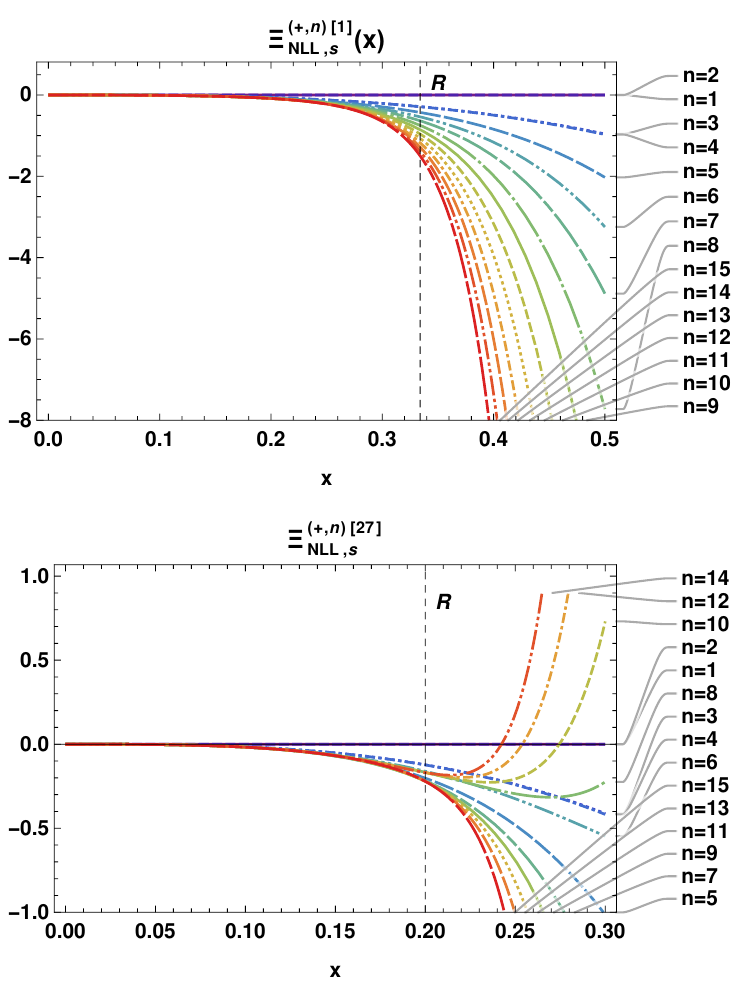
Figure 10 . Partial sums of the soft component of the infrared-renormalized amplitude coe(cid:14)cients (cid:4) (+ ;‘ ) , up to 15th order, for the singlet (upper plot) and 27 colour representation (lower plot). NLL ; s The dashed vertical line represents the radius of convergence, R , determined from the resummed